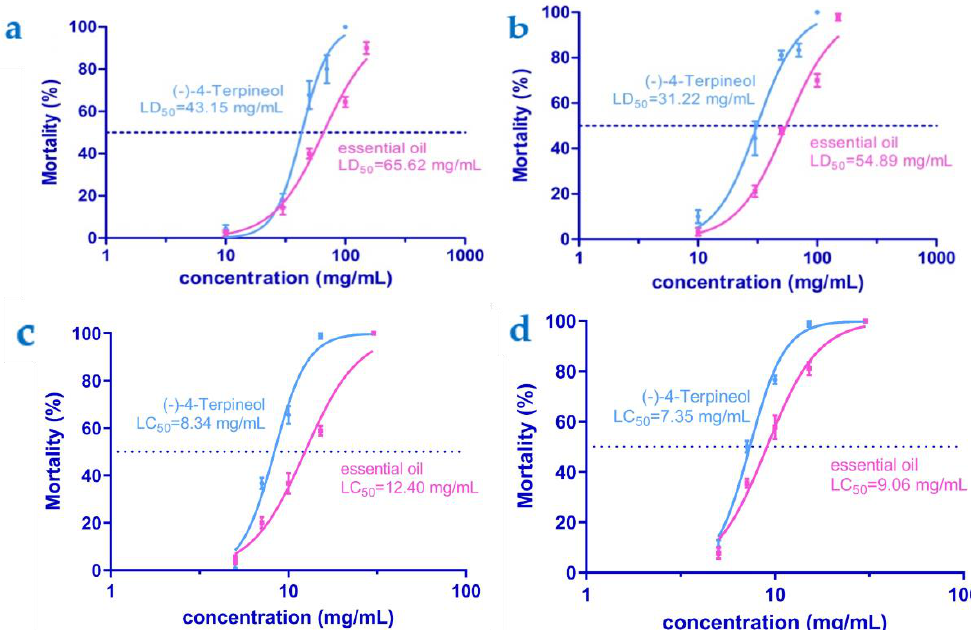
Figure 4. Contact toxicity ( a , b ) of (-)-4-terpineol and the essential oil of A. lavandulaefolia against P. xylostella larvae and their fumigant toxicity ( c , d ) against P. xylostella adults, at 12 and 24 h post treatment, respectively. Vertical bars represent standard error of the mean. The curves have been drawn from the insect mortality at five concentrations using GraphPad Prism 5.0. Lethal dosage (LD) and lethal concentration (LC) values were estimated based on a concentration–mortality bioassay using probit analysis. LD 50 : Lethal dosage that kills 50% of the exposed larvae, expressed in mg/mL. LC 50 : Lethal concentration that kills 50% of the exposed adults, expressed in